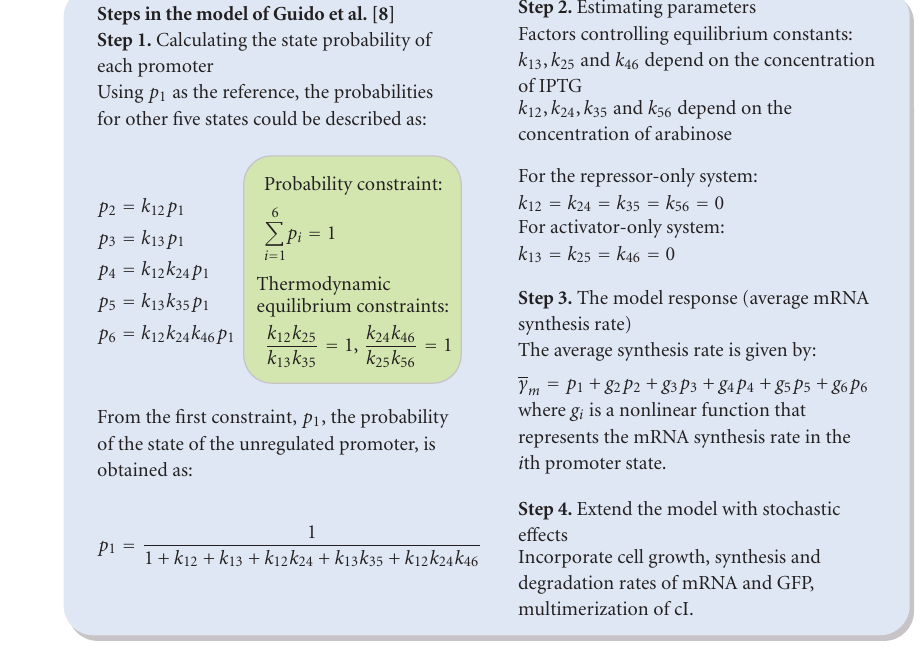
Figure 9: Steps in the repressor-activator mathematical model in Guido et al. [8].